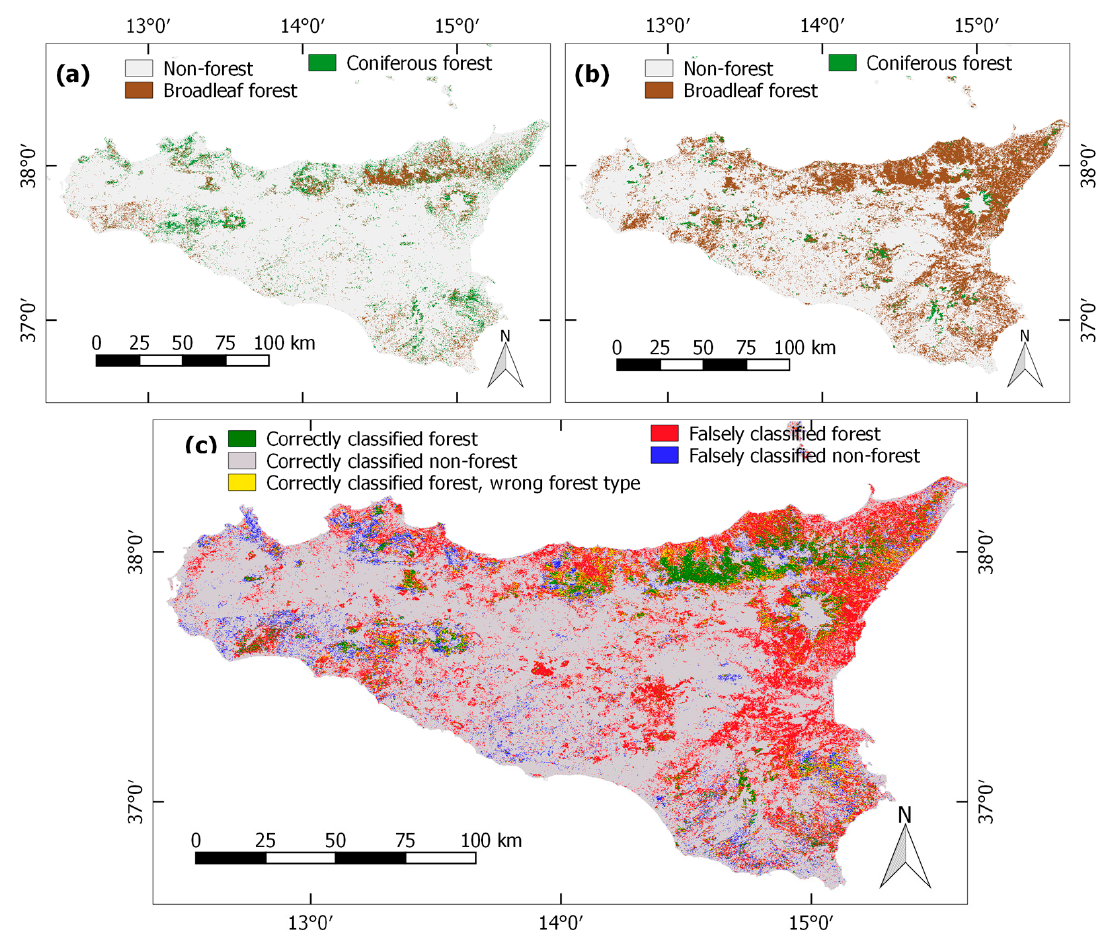
Figure 8. Detailed forest type map over Sicily from ( a ) Sentinel-1, ( b ) Copernicus High Resolution Layers and ( c ) the difference map between the two datasets.